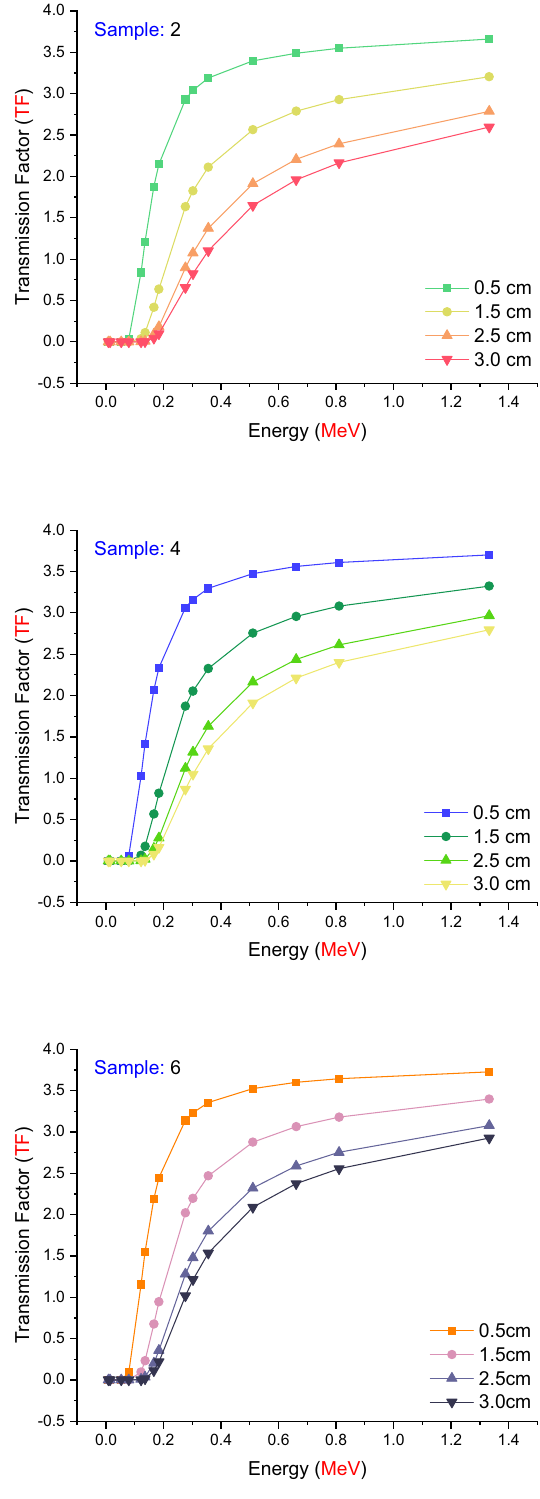
Figure 9: TFs of investigated glasses as a function of used radioisotope energy ( MeV ) at di ff erent glass